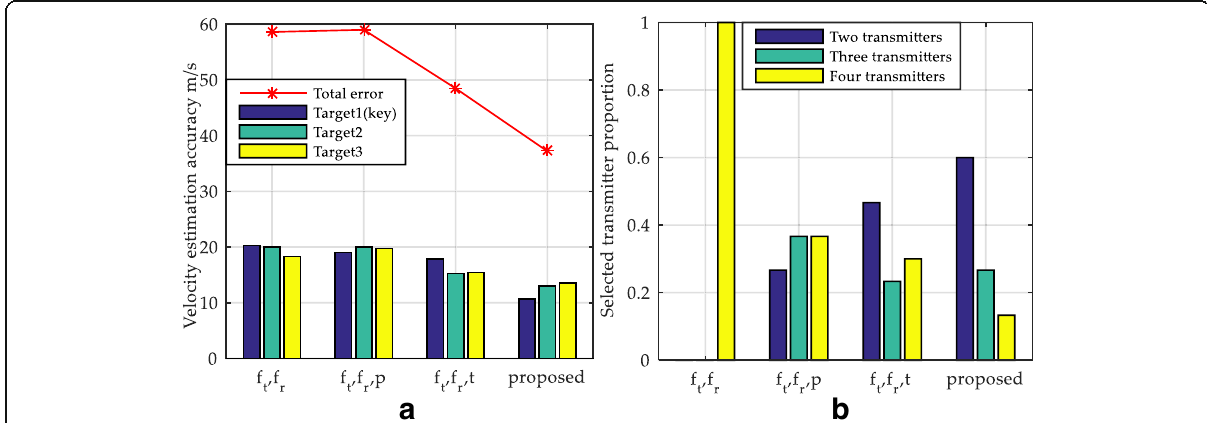
Fig. 7 Velocity estimation accuracy and transmitter number at random layout MSE = [inf, 20 2 , 20 2 ]m 2 /s 2 . a Velocity estimation accuracy b Transmitter